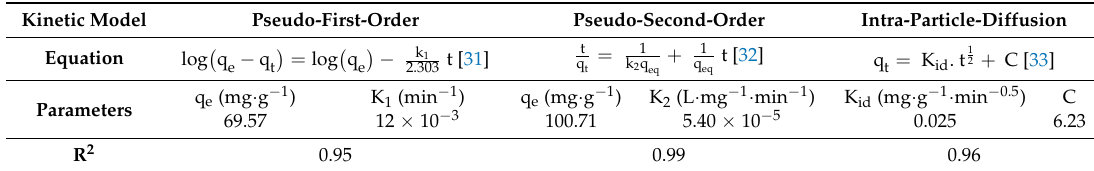
Table 3. Kinetic parameters of ARS